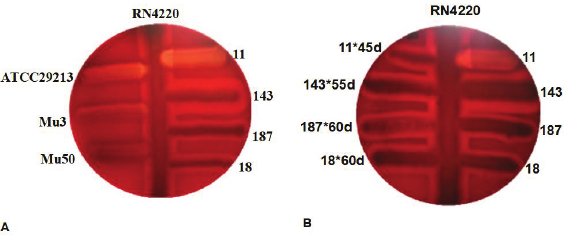
Figure 6: The δ-hemolysin production in parental and derivated strains. β-hemolysin producing strain RN4220 is streaked vertically and the test strains are streaked horizontally. The VSSA strain ATCC29213 was used as a positive control, the hVISA strain Mu3 negative controls. Figure 7: The biofilm formation of four pairs of parental and deriva- ted strains (*P<0.05). The results were done in triplicates.